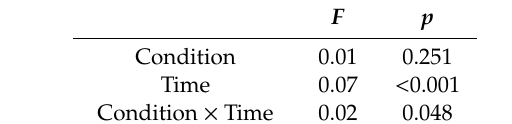
Table 1. The 2 × 2 repeated measure ANOVA results testing the intervention e ff ect.